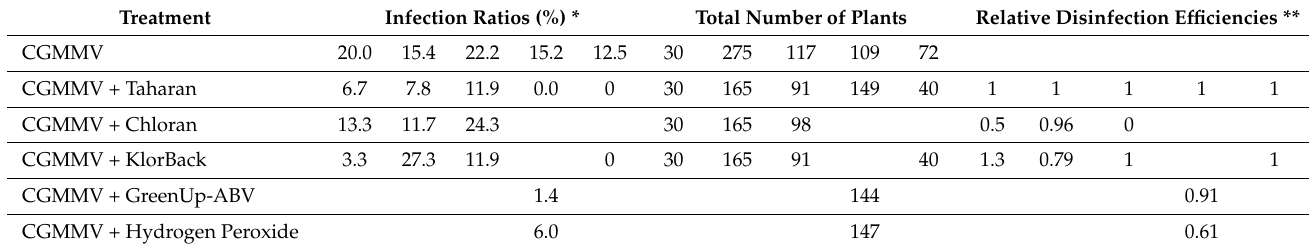
Table 2. Relative disinfection efficiencies of CGMMV infested sandy